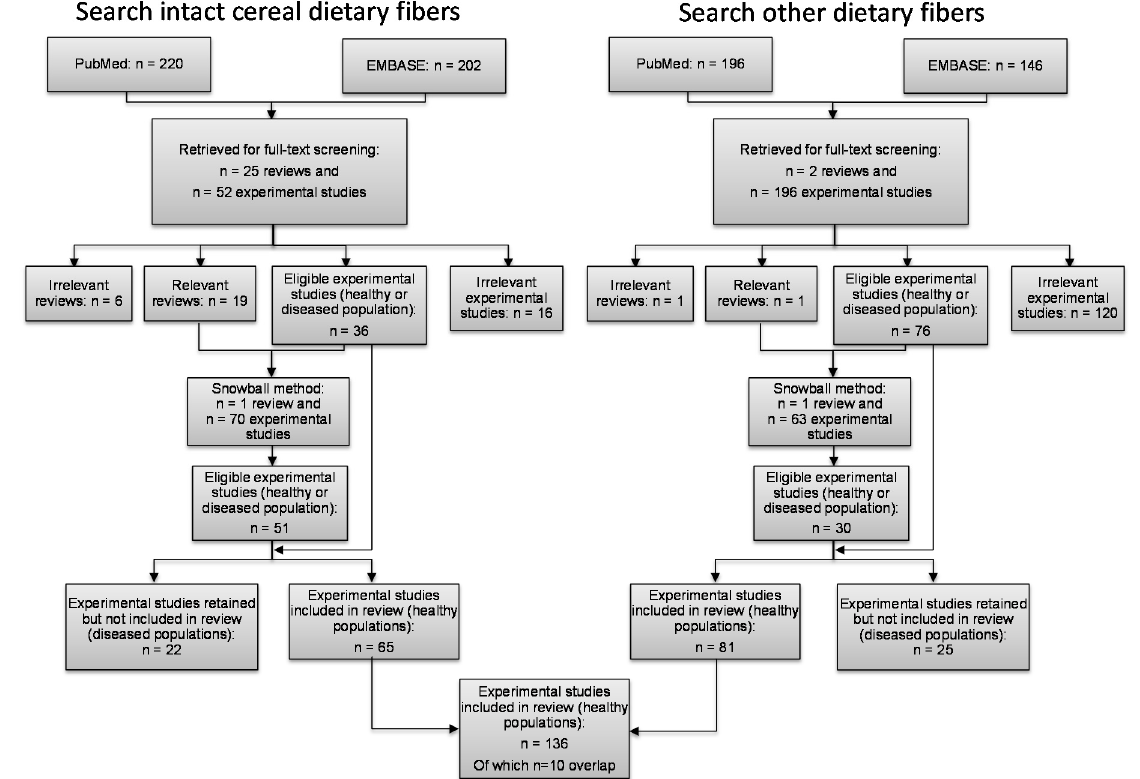
Figure 1. Search flow to identify and review publications. The figure shows the studies identified for inclusion in the review on the effects of dietary fiber on fecal weight and transit time. The overlap between the two searches indicates publications that tested dietary fibers from cereals and other sources.